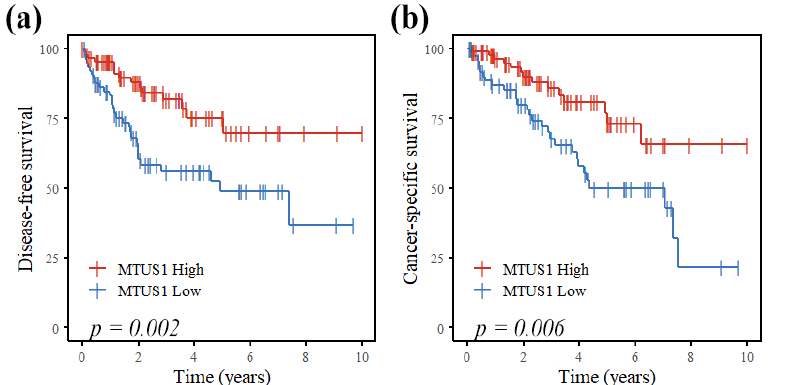
Figure 2. Cumulative disease-free ( a ) and cancer-specific ( b ) survival curves according to MTUS1 expression by immunohistochemistry in lung adenocarcinoma patients. There was significant difference in both disease-free and cancer-specific survival (Kaplan–Meier method with log-rank test).